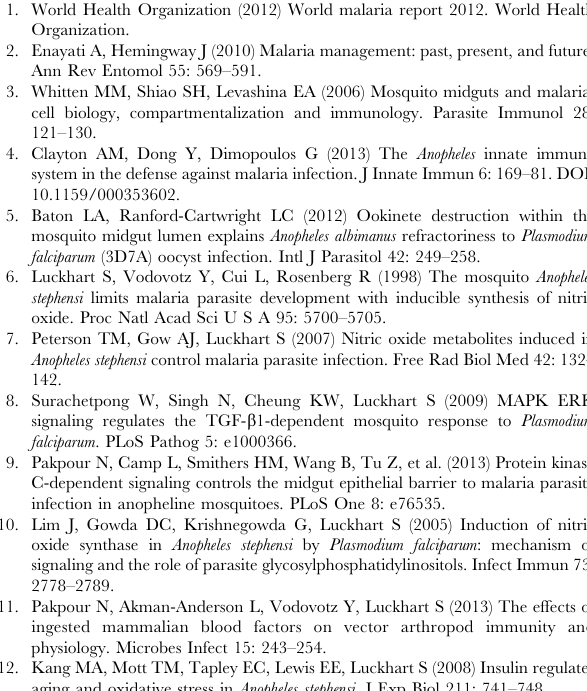
Figure S1 Raw (non-normalized) data from Figure